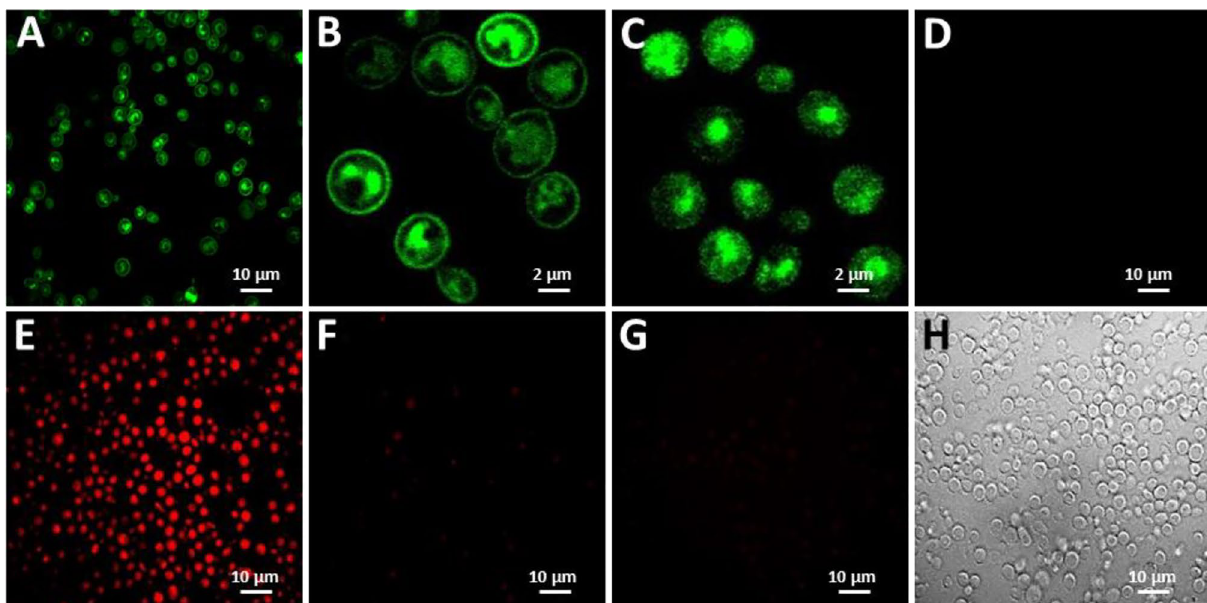
Figure 1. Detergent-resistant cell wall of yeast enables physical linkage between the phenotype and genotype of membrane-expressed A2aR. ( A , B ) Fluorescent confocal microscope images of yeast expressing WT-A2aR- eGFP (C-term) fusion. Some receptors appear to be trapped in ER. ( C ) A2aR-eGFP-expressing cells after 4 h incubation with 2% OG. The plasma membrane is dissolved and eGFP fluorescence is scattered throughout the cell volume. ER-retained receptors are visible. ( D ) Confocal microscope images of intact yeast expressing A2aR-WT (without eGFP) incubated for 1 h with 20 nM fluorescent A2aR agonist CA200623. Intact cells are impermeable to the ligand. ( E ) As in ( D ), only incubation with CA200623 was performed after yeast permeabilization by a brief (1 min) exposure to 1% OG. Membrane-expressed A2aR is properly folded and able to bind the fluorescent ligand. ( F ) Cells not expressing A2aR were treated as in ( E ). ( G ) As in ( E ), followed by 4 h incubation with 2% OG (in the presence of CA200623). The fluorescent signal is lost as a result of A2aR-WT denaturation. ( H ), Yeast cells treated with 2% OG for 4 h maintained their shape and mechanical integrity (white to molecules as small as CA200623 (925 Da), a fluorescent analog of adenosine receptor agonist NECA (Fig. 1D). However, cells that were exposed briefly (1 min) to 1% OG prior to CA200623 addition produced a strong fluorescent signal (Fig. 1E), which was absent in control cells, which did not express A2aR-WT (Fig. 1F). This indicates that the brief exposure to 1% OG was sufficient to perforate the cell wall, providing CA200623 with an access to membrane A2aR, while it was not harsh enough to denature A2aR-WT, which maintained its ability to bind the ligand. The integrity of the plasma membrane, however, appears to be compromised by the treat- ment, possibly resulting in membrane fragmentation, as could be inferred from the confocal microscope images demonstrating a homogeneous distribution of the fluorescent signal throughout the cell volume (not limited to plasma membrane) (Fig. 1E). The notion that cell membrane was irreversibly damaged by the brief exposure to 1% OG is consistent with the inability of the cells to recover after the treatment (Supplementary Fig. S1). In contrast to the brief exposure to 1% OG, a prolonged (> 2 h) incubation with 2% OG resulted in a complete loss of the fluorescent signal in A2aR-WT expressing yeast (Fig. 1G), indicating membrane dissolution and the